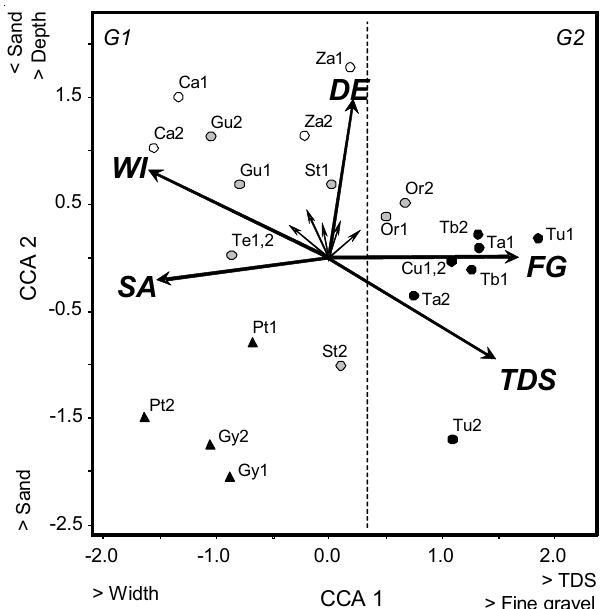
Fig. 4. Pattern in fish assemblages distribution among envi- ronmental variables based on canonical correspondence analysis ordination. Labeled arrows indicate the direction along which each variable changes most. The arrows were doubled in length for visual purposes. The gradient is domi- nated by the variations of depth (DE), fine gravel (FG), total dissolved solids (TDS), sand (SA) and width (WI). Each symbol represents a sampling location and degree of distur- bance: open circle (low disturbance), gray circle (medium), black circle (high) and triangle (very high).